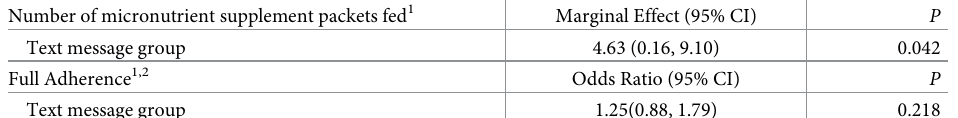
Table 2. Intent-to-treat analysis of the impact of daily text messages on caregiver feeding adherence: Rural Shaanxi Province, 2013. Number of micronutrient supplement packets fed